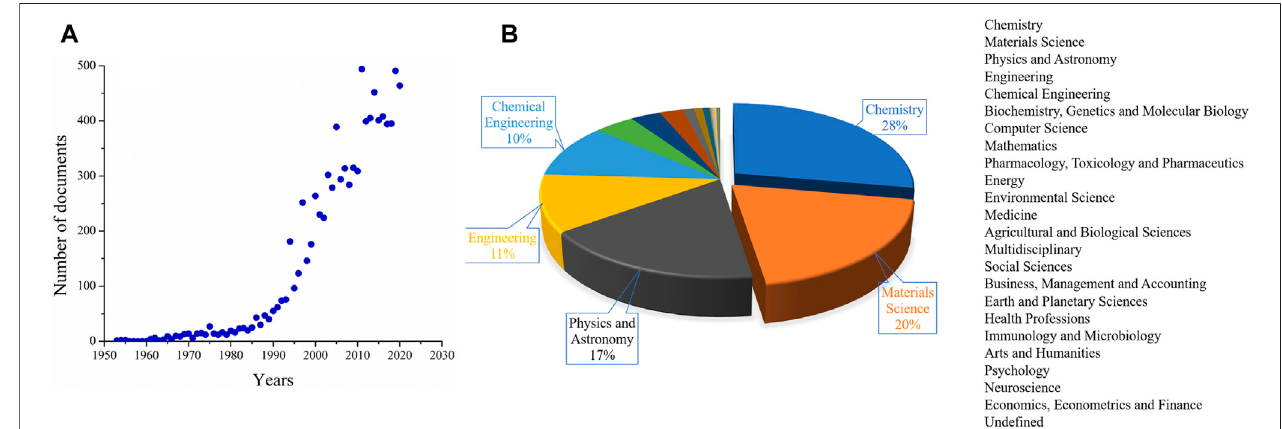
FIGURE 1 | (A) Number of publications per year and (B) distribution areas of publications based on the Scopus database